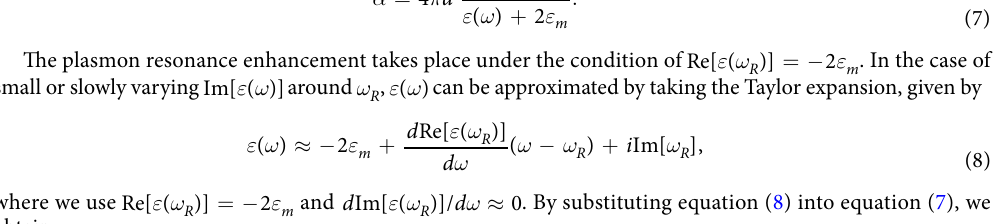
is the plasma frequency and the red P